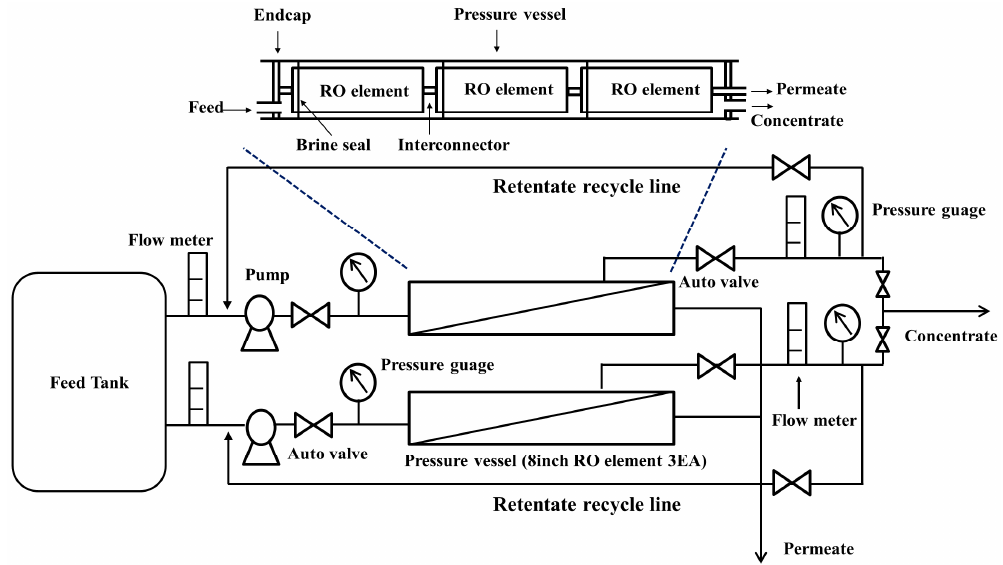
Figure 1. Schematic diagram of mobile long-term test machine.